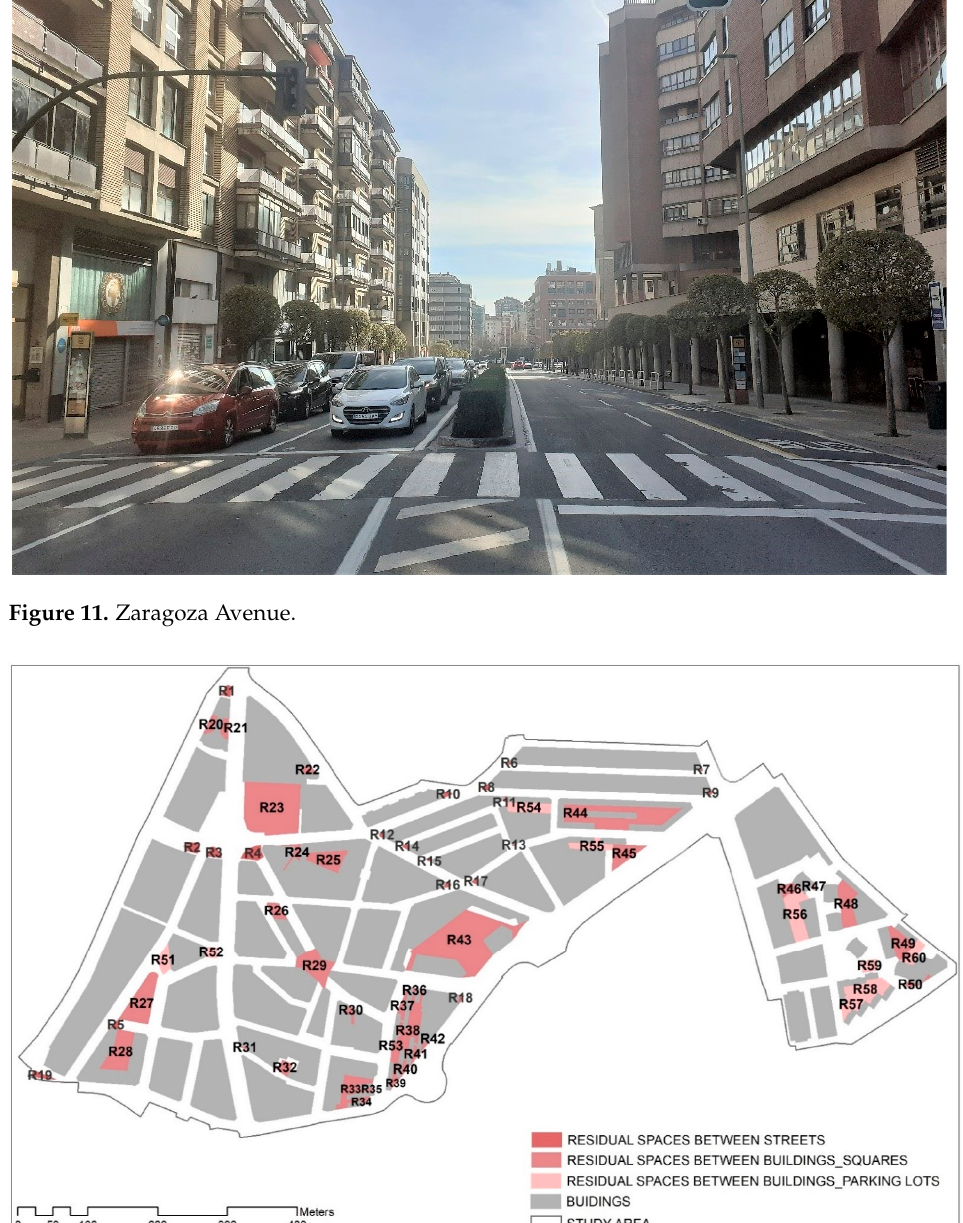
Figure 13. Map of vertical residual spaces of La Milagrosa: walls and party walls.